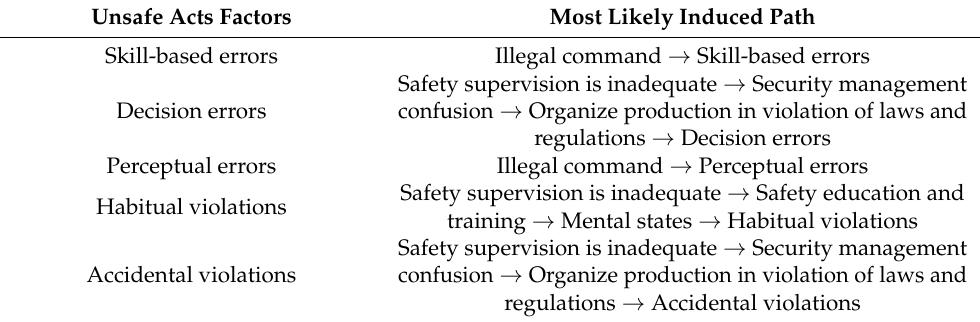
Table 9. Summary of main induced paths of unsafe acts.